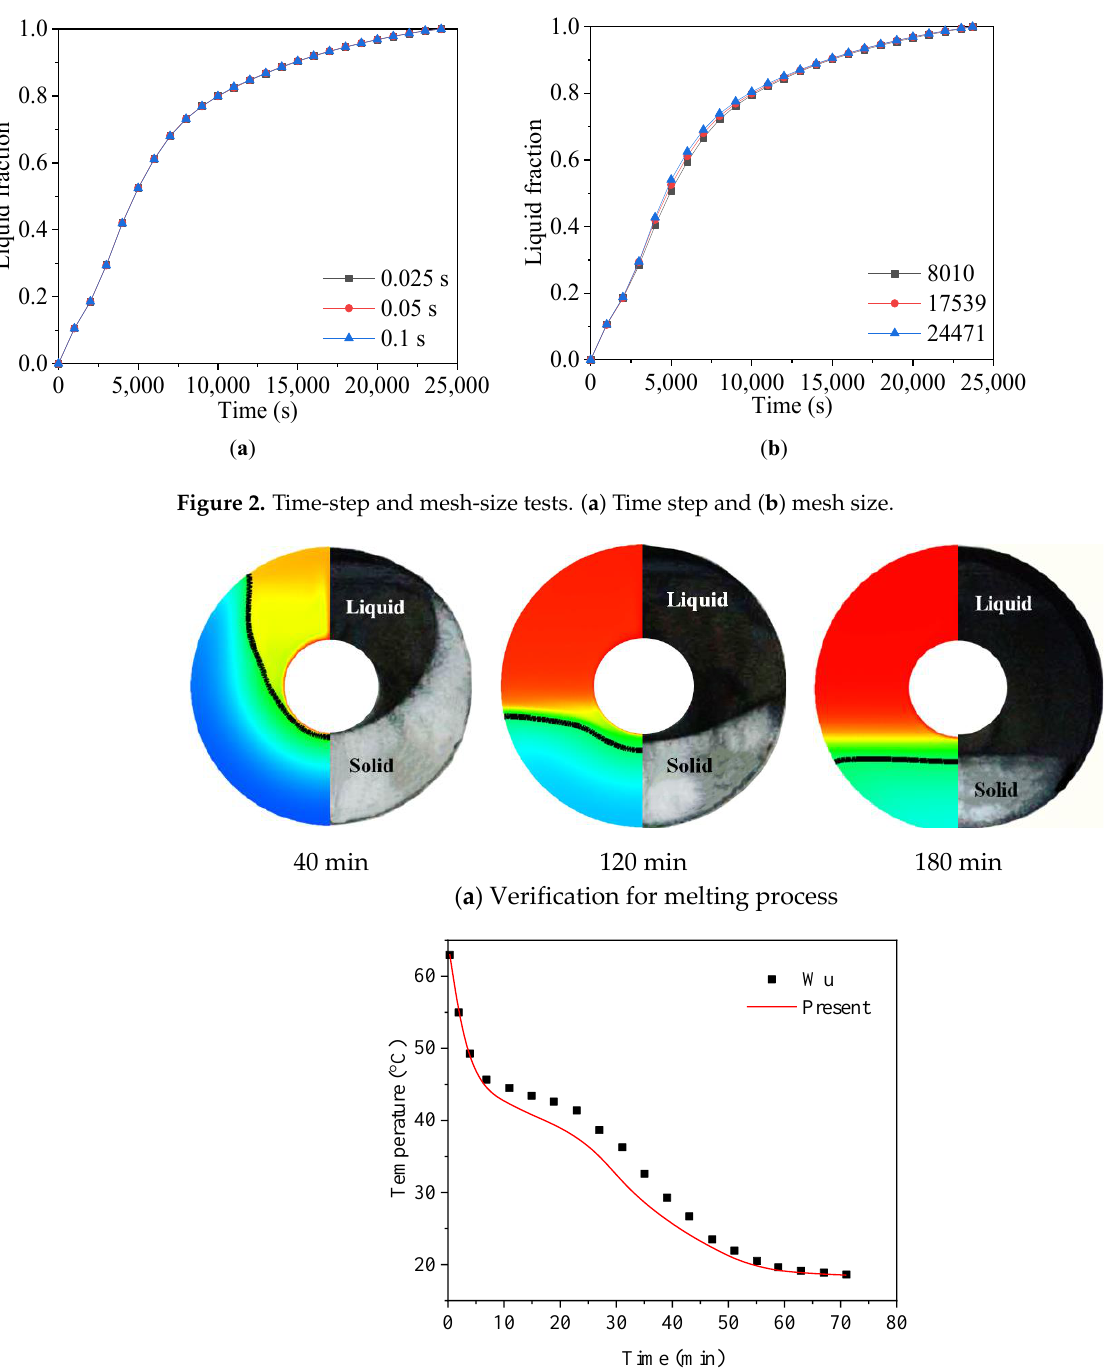
Figure 22. Thermal penetration and thermal uniformity for Cases 10, 14 – 16.